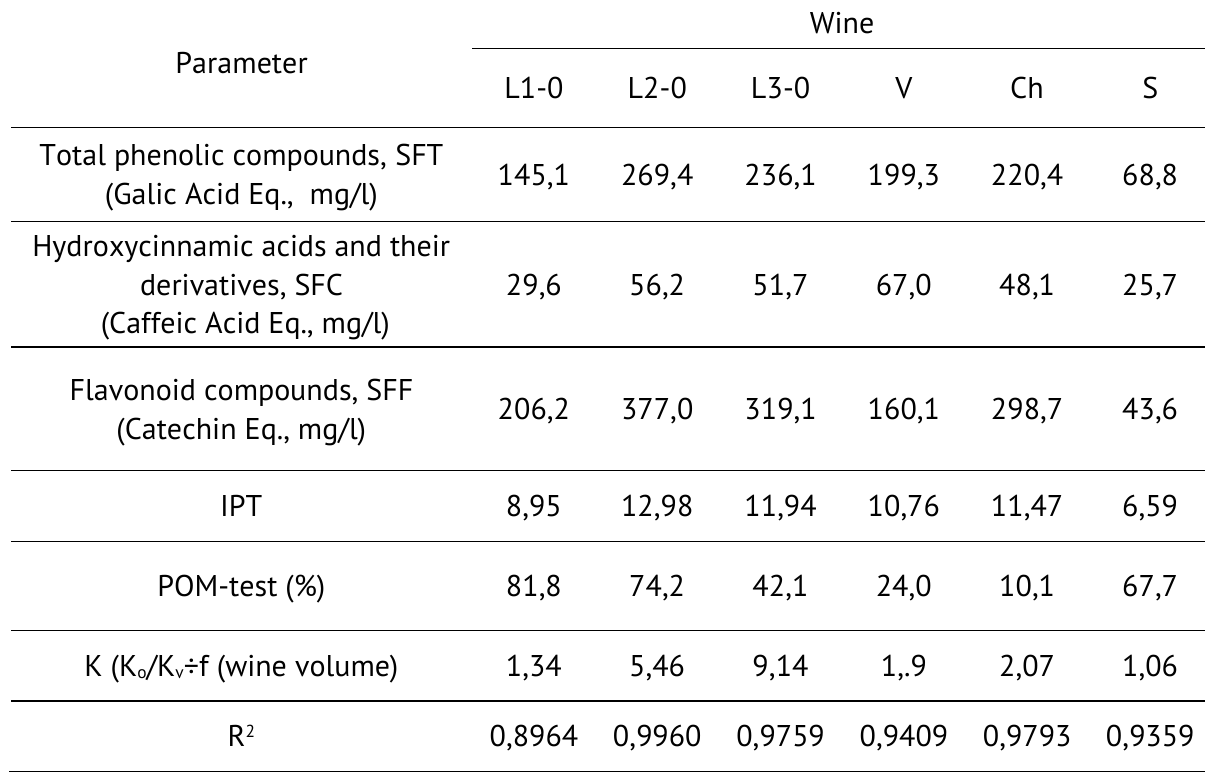
The concentrations of main phenolic compounds, the index of oxidation behavior (POM- test) and the parameter of relative antioxidant capacity